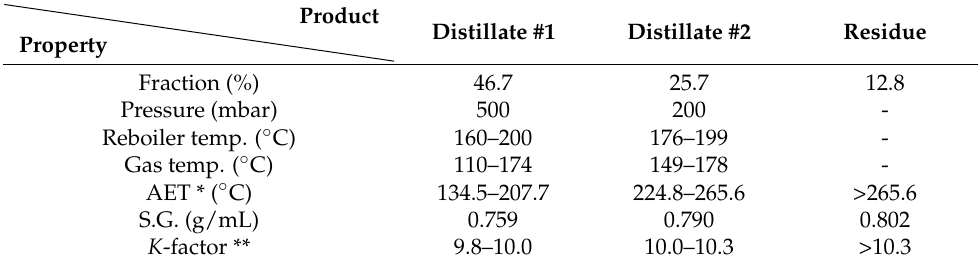
Table 1. Properties of fractionally distilled